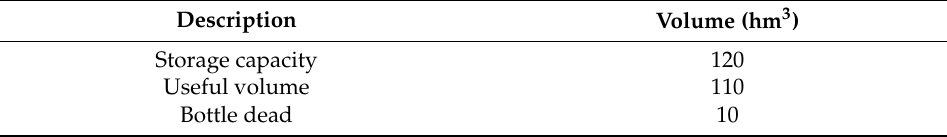
Table 5. Reservoir